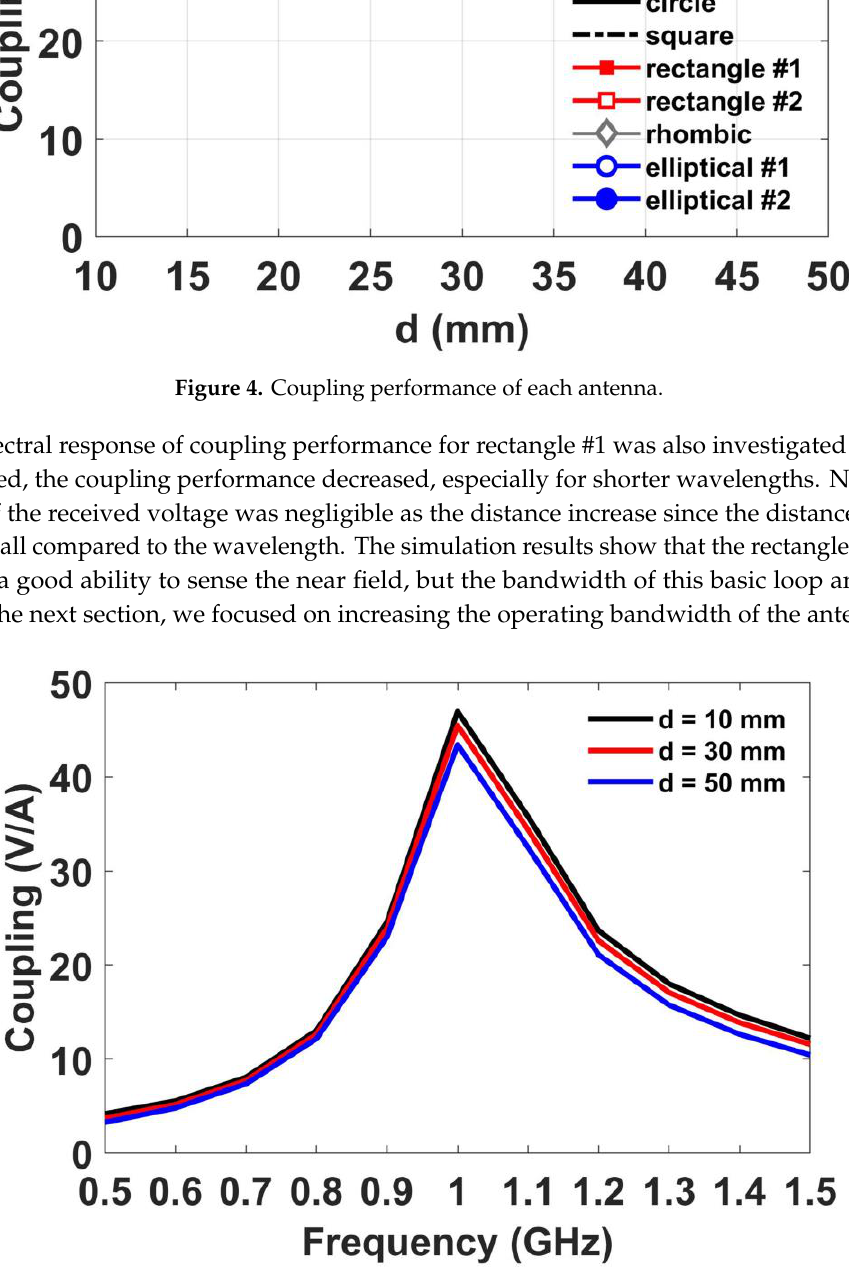
Figure 5. Coupling performance by rectangle #1 versus frequency.